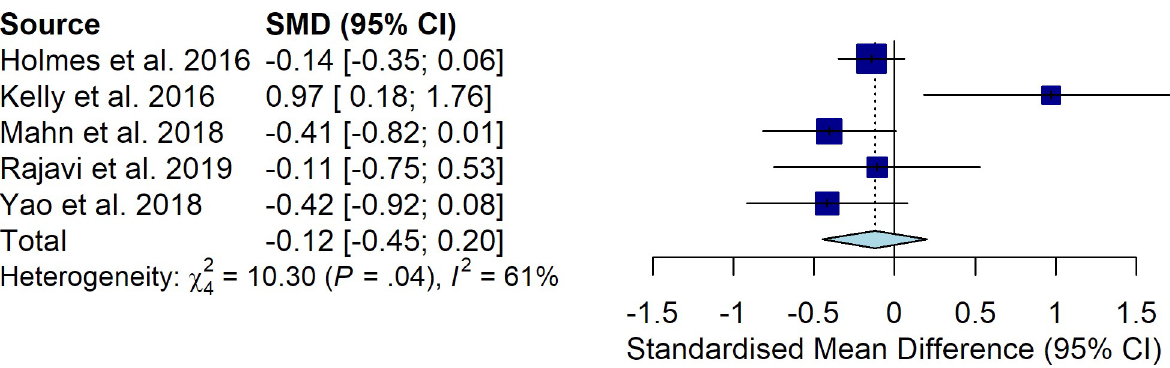
Fig 2. Difference in VA between patients treated with binocular treatment versus